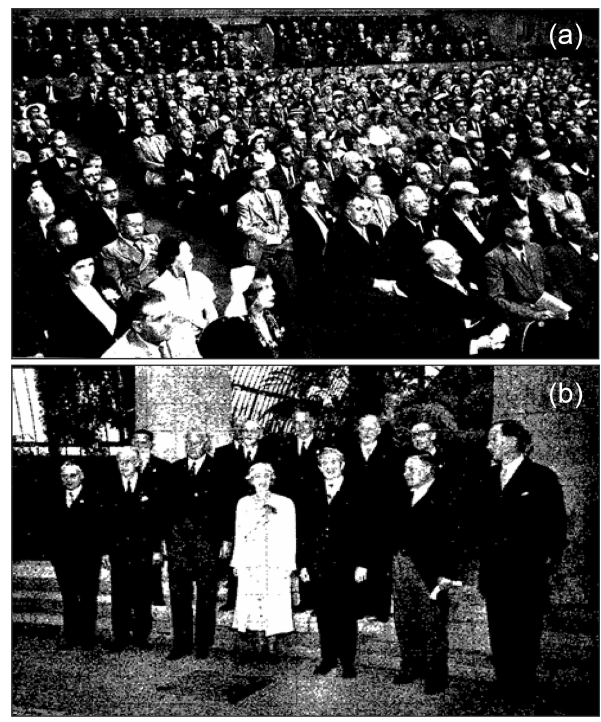
Figure 1. IX General Assembly of IUGG. (a) Opening Ceremony at the Palais des Beaux-Arts, Brussels. (b) Members of the IUGG Bureau, the Belgian National Committee for Geodesy and Geo- physics, and the Association Presidents meeting H.M. Queen Elis- abeth of Belgium at Château Royal de Laeken (Cox,